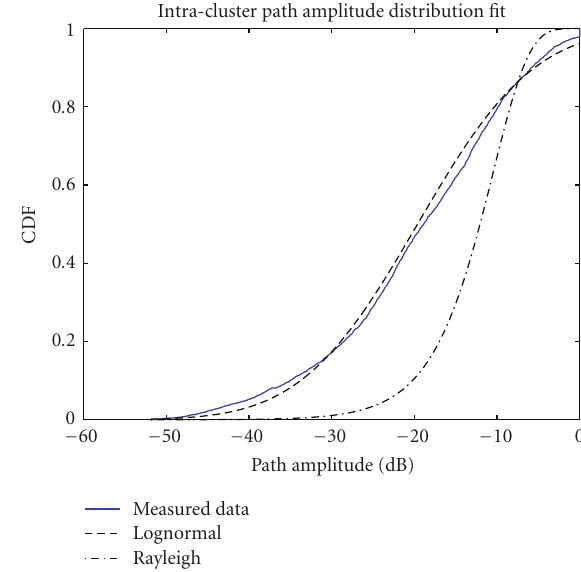
Figure 16: Cluster amplitudes CDF with the best-fit Rayleigh (RMSE = 0.0840) and lognormal (RMSE = 0.0661) distributions for measurements inside the Taurus engine compartment.